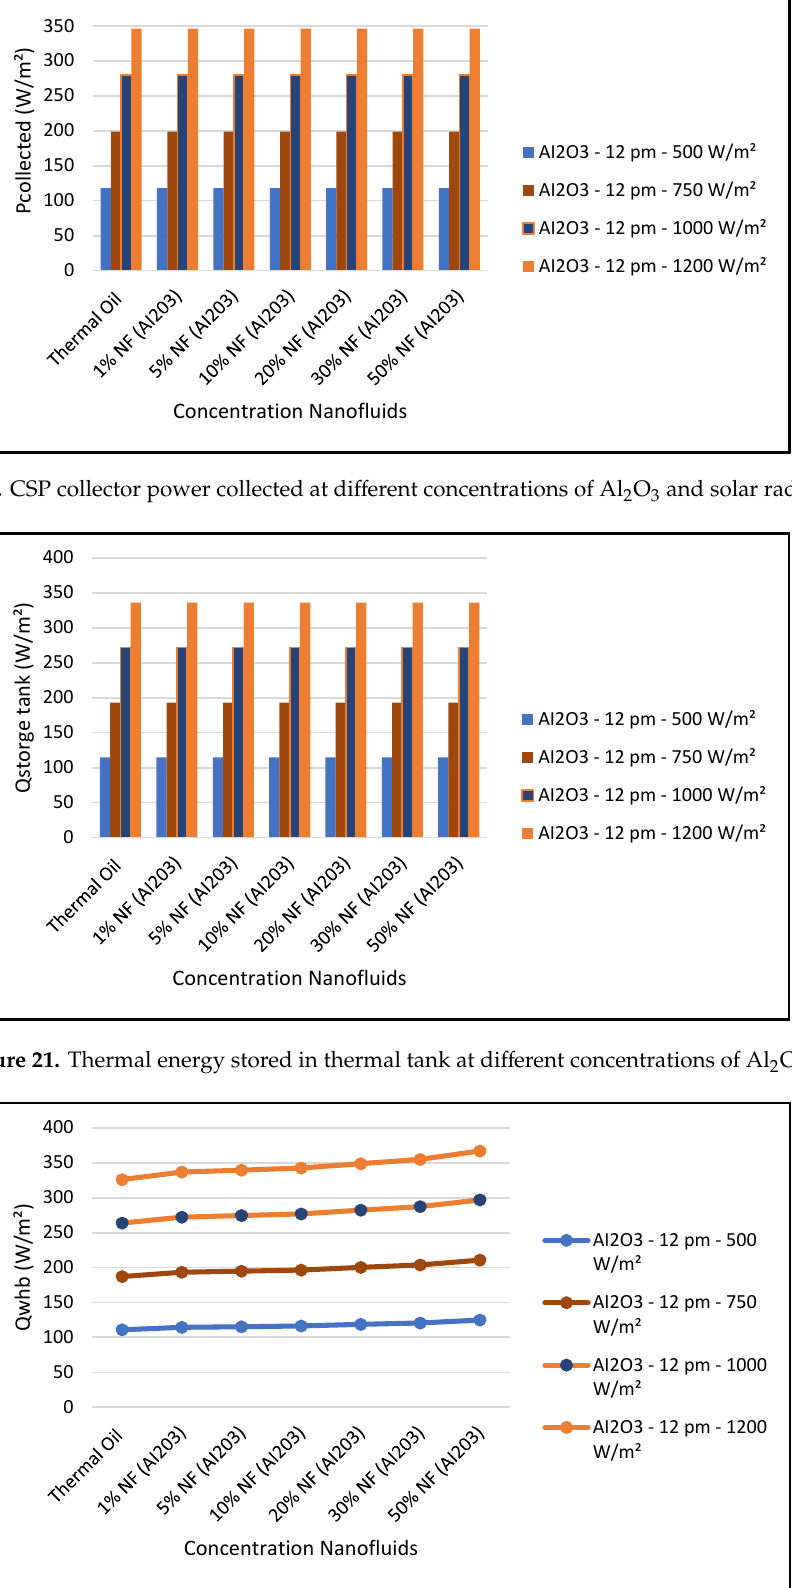
ff erent concentrations of Al 2 O 3